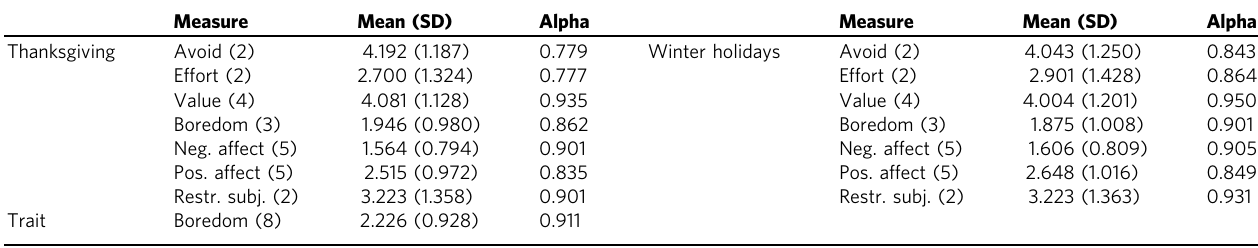
Table 1 Descriptive summary of measures.